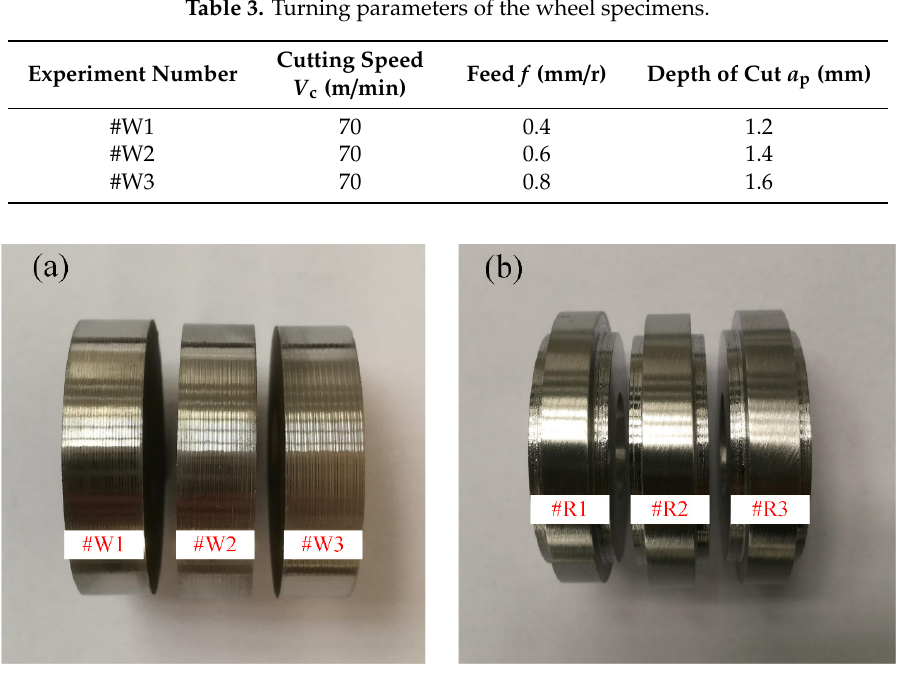
Figure 2. SEM micrographs of wheel/rail specimens: ( a ) wheel steel; ( b ) rail steel.